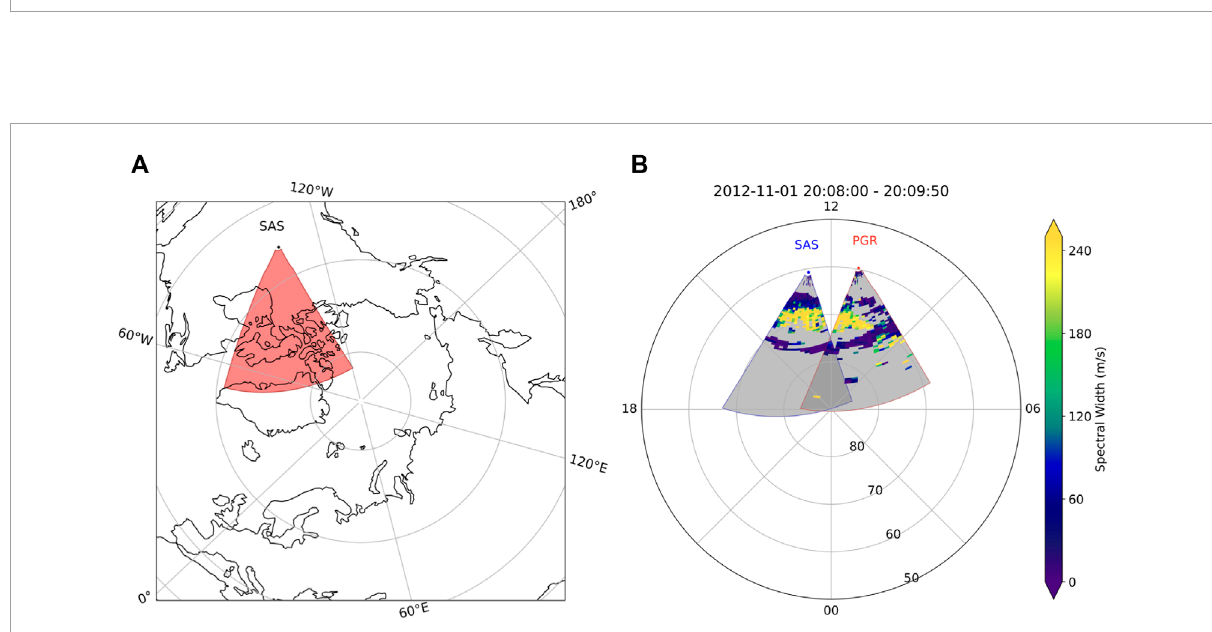
FIGURE 5 FOV plot (left) for the Saskatoon radar and fan plot (right) for the Saskatoon and Prince George radars at 20:08 UT on 1 November